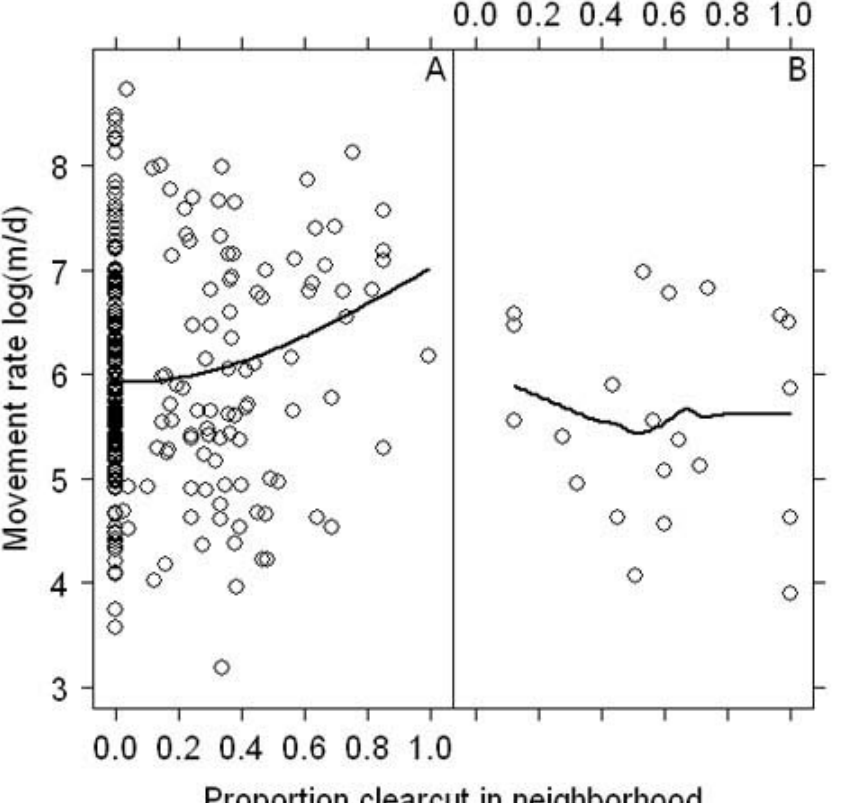
Fig. 6. Scatter-plot illustrating movement rate interaction between the proportion of clearcut land cover at the neighborhood scale and the proportion of clearcut land cover along an individual’s movement path for Yellow-rumped Warblers. (A) 0 – 35% of buffer surrounding movement path composed of clearcut land cover. (B) 35 – 70% of buffer surrounding movement path composed of clearcut land cover. Trends illustrated with locally weighted regression